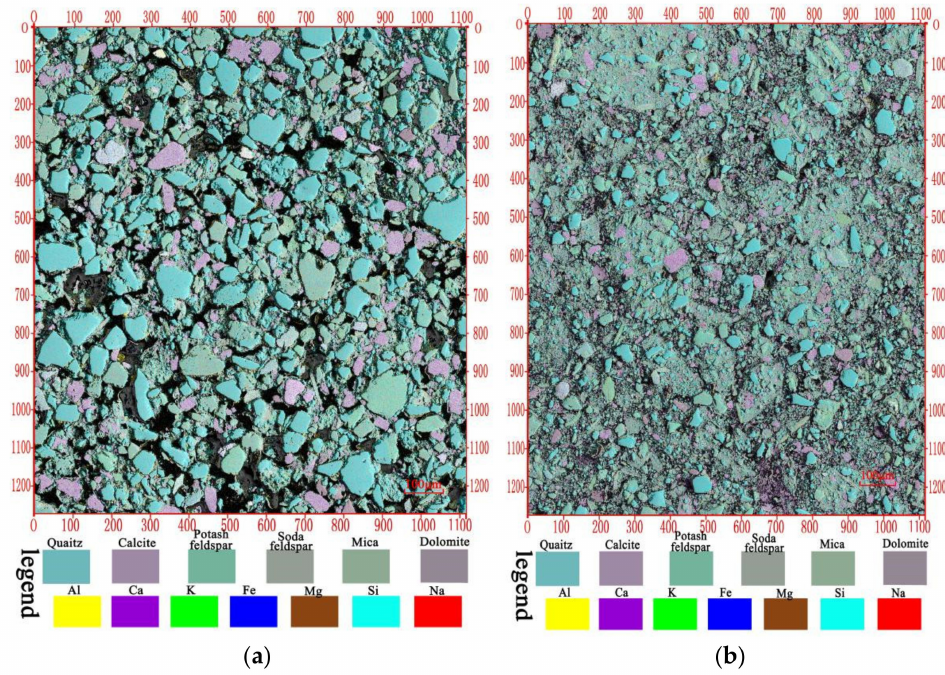
Figure 2. Multi-scale microstructure of undisturbed loess and lime-treated loess from Xining. ( a ) Undisturbed loess; ( b ) Lime-treated loess.